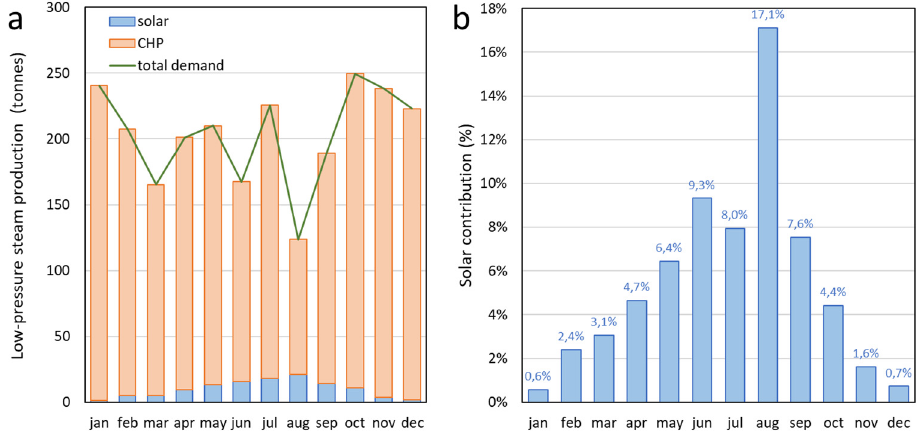
Figure 9. ( a ) Low-pressure steam demand profile and monthly distribution of accumulated steam production by the existing cogeneration (CHP) and the proposed solar plant at the Italian distillery; ( b ) monthly distribution of the solar contribution fraction to the low-pressure steam production.